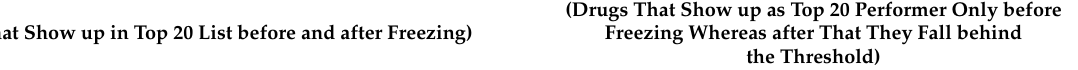
Table 3. The list of stable and unstable drugs for